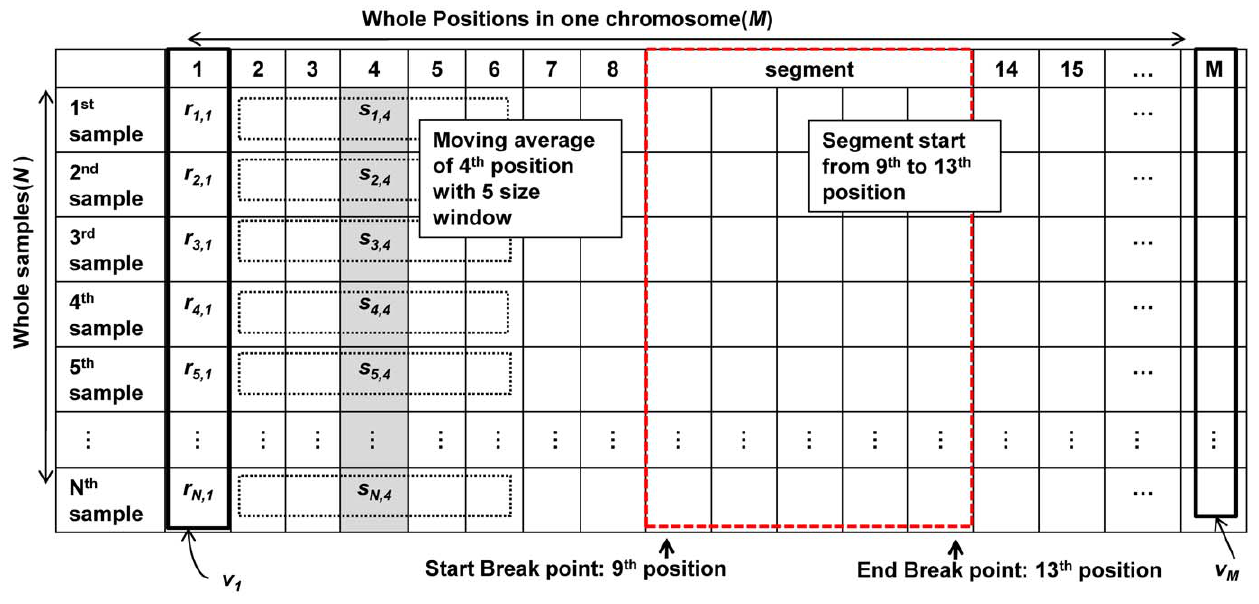
Figure 9. Multi-sample aCGH data and notations used in this paper. Descriptions of the notations used in the paper are provided in Table 1. The left, black-dotted rectangle containing s i,j indicates the window used for the moving average. The right, dotted, red rectangle indicates a segment.